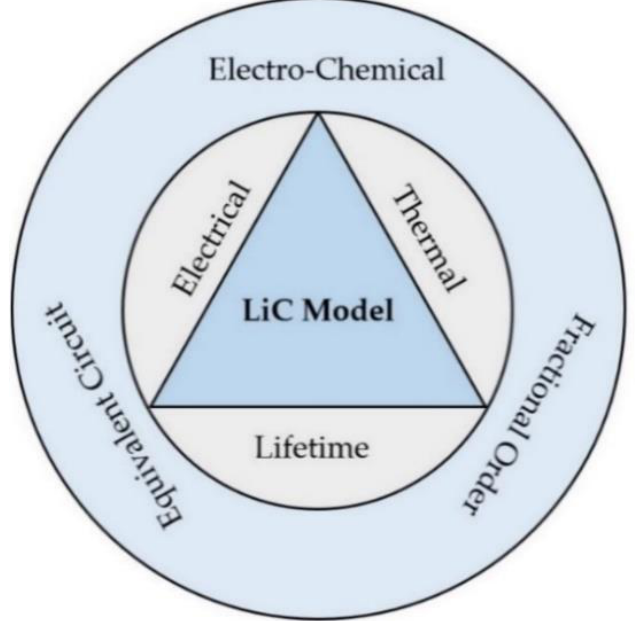
Figure 7. The holistic model of the LiC is applicable for real-time energy management and control purposes